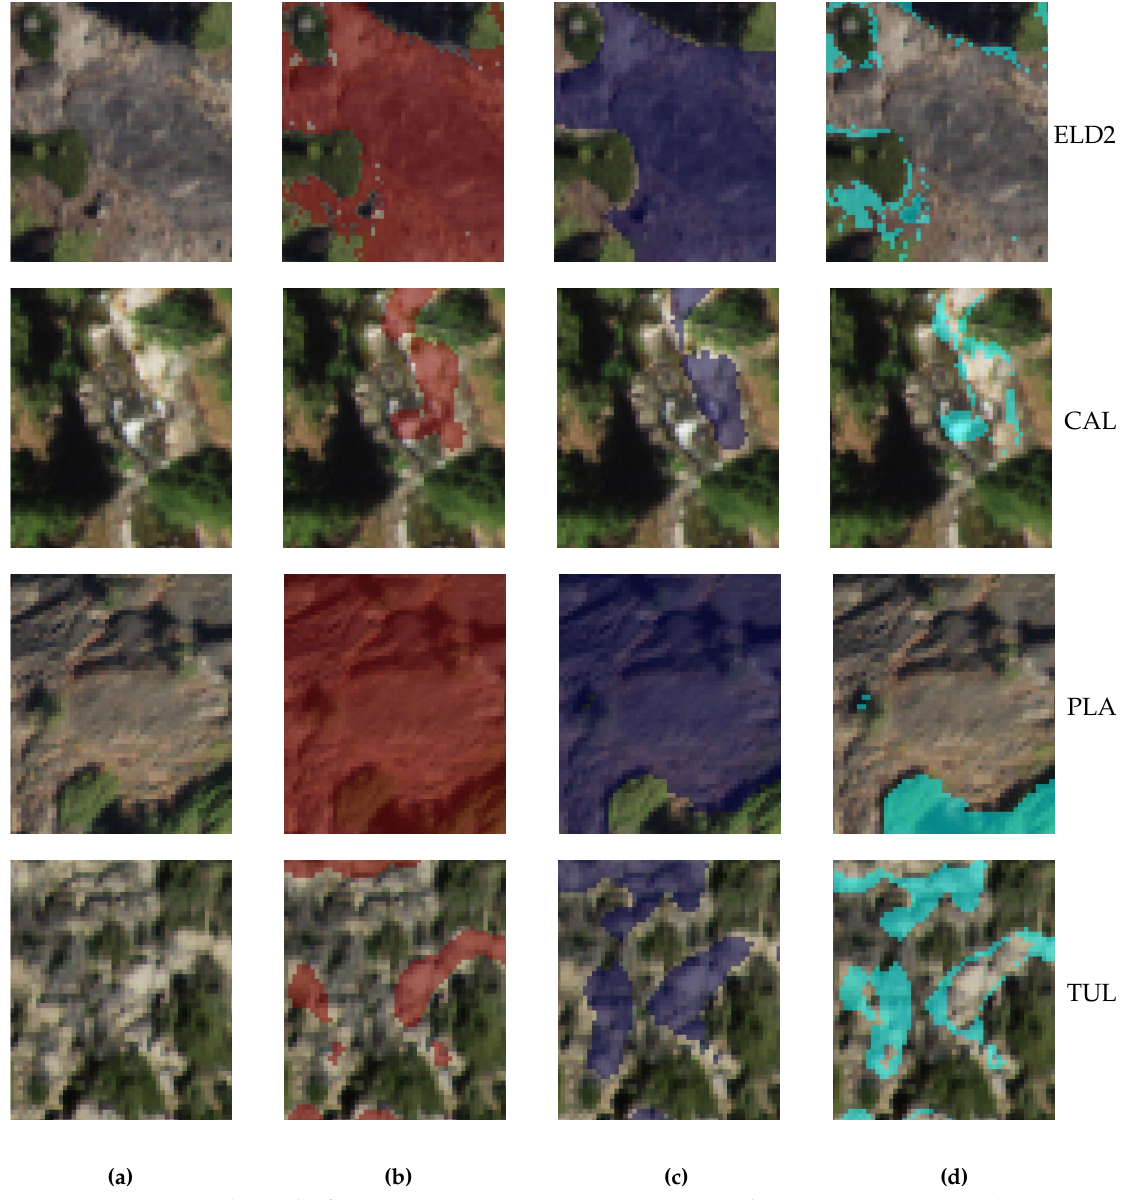
Figure 12. Sample results from 4 test sites: ( a ) input image; ( b ) initial mapping; ( c ) CNN prediction; ( d ) difference between prediction ( c ) and initial mapping ( b